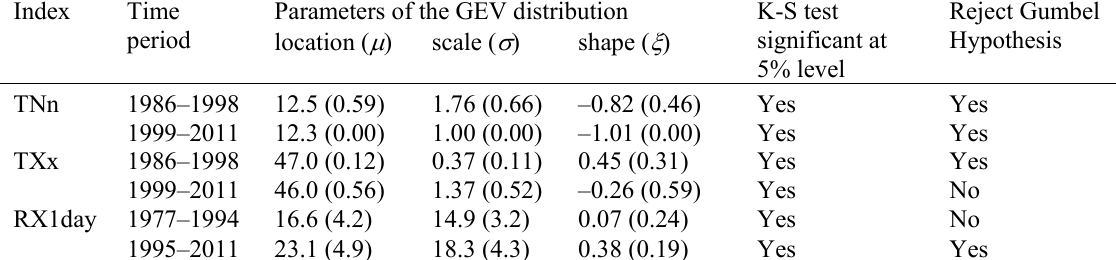
Table 3 Estimated parameters of the Generalized Extreme Value (GEV)